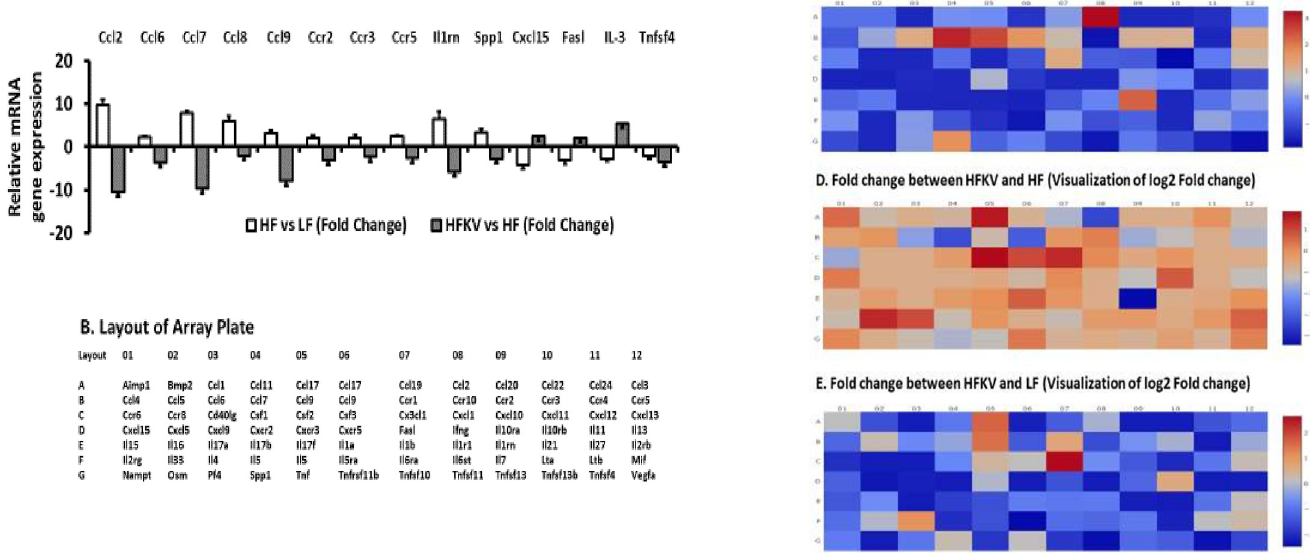
Fig 6. Fold change in gene expression of inflammatory cytokines, chemokines and receptors in adipose tissue. cDNA was synthesized using the RT 2 first strand kit and using the RT 2 Profiler TM PCR Array, the differential expression of the chemokines, cytokines and receptors was determined. (A). The HFD diet increased ten chemokines and chemokine receptors by over 3.0-fold and the HFKV diet reduced these. The HFD reduced 3 cytokines and the HFKV diet increased them. All genes shown were changed by over 3.0-fold and were statistically different at P < 0.05 after paired T tests. (B). The layout of the PCR array plate. (C-E). Heat maps displaying changes between the HFD and LFD, HFD and HFKV and HFKV and LFD respectively.